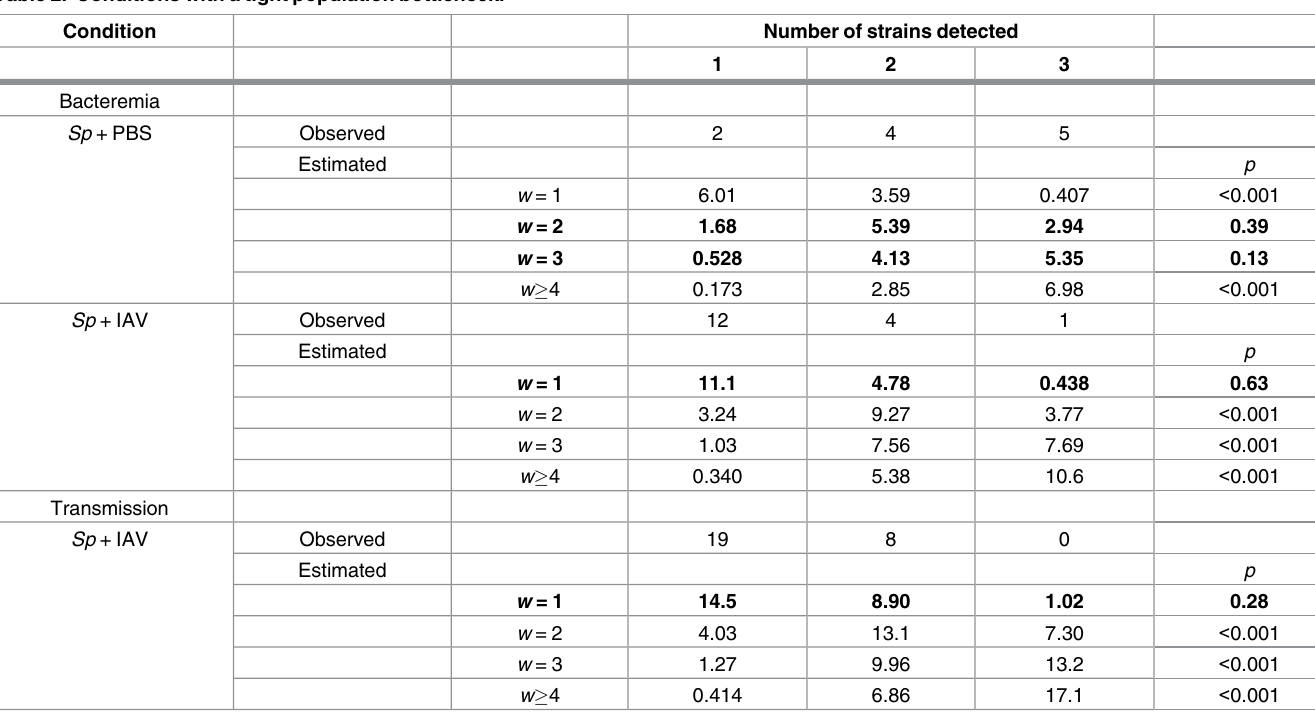
Fig 3. Analysis of tight population bottlenecks. A. A tight populationbottleneck exists in bacteremiaafter IN challenge.Pups were inoculated with three mutant mixture on day 4 and IAV (above) or PBS (below) on day 8 of age. Data with IAV is from three representative experiments. Each vertical tick mark on the x-axis represents results of blood cultures obtainedwhen the pups showed signs of sepsis from one pup. B. Most transmission events originatefrom a single organism. Two representative litters out of five are shown. One pup was inoculatedwith each of three marked mutants on day 4 of age (index mice) and returned to the littermates (contacts). C. Multiple entry events may occur during transmission. Three pups were each inoculatedwith one of the three marked mutants on day 4 of age (index mice) and returned to the littermates (contacts). B, C. On day 8, all pups were infected with IAV. The bacterial density in the nasal lavage of each mouse on day of age 12 is shown. Each vertical tick mark on the x-axis represents results of cultures nasal lavages from a single pup.